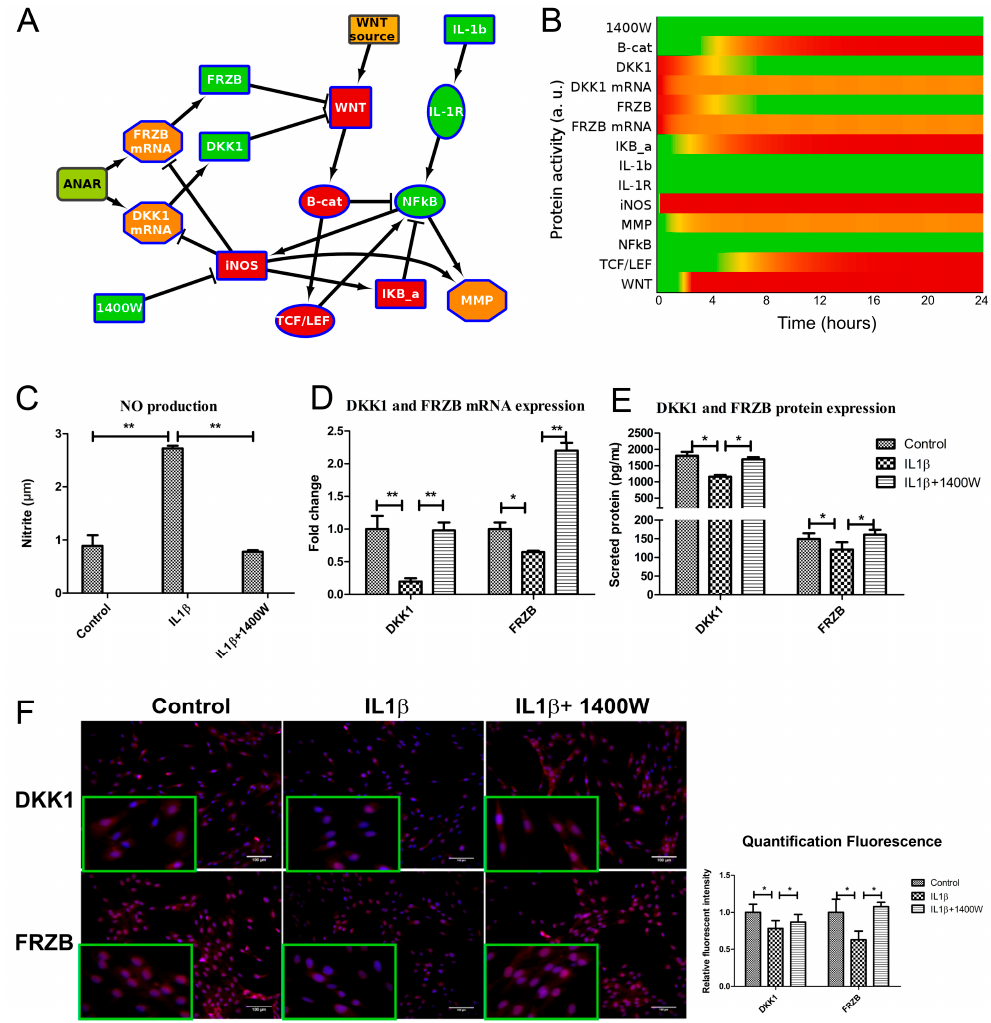
Figure 5. iNOS inhibitor 1400W blocked NO production and rescued the expression of DKK1 and FRZB both in the computational model and in cells. ( A , B ). Addition of 1400W to model 2, creating model 3, shows WNT inactivation by relieving the brake on DKK1 and FRZB expression. Activity levels at 24 h are shown. As shown in Figure 2A, Green is active, red inactive. IL-1b = IL1 β , B-cat = β -catenin (protein), IKb-a = I κ B α . The model with auto-inhibition edges is shown in Figure S5. ( C ) Human chondrocytes were treated with either IL1 β or 1400W or both for 24 h. 1400W inhibited IL1 β induced NO production, as measured by Griess assay. ( D , E ). The mRNA and protein expression of DKK1 and FRZB was rescued after addition of iNOS inhibitor, measured by qPCR and ELISA ( F ). The protein expression of DKK1 and FRZB was also measured by immunofluorescence (scale bar 100 µ m), magnified pictures were indicated in inserts. Quantification of immunofluorescence intensity was performed by CellProfiler software. * p < 0.05, ** p < 0.01: significant correlation.